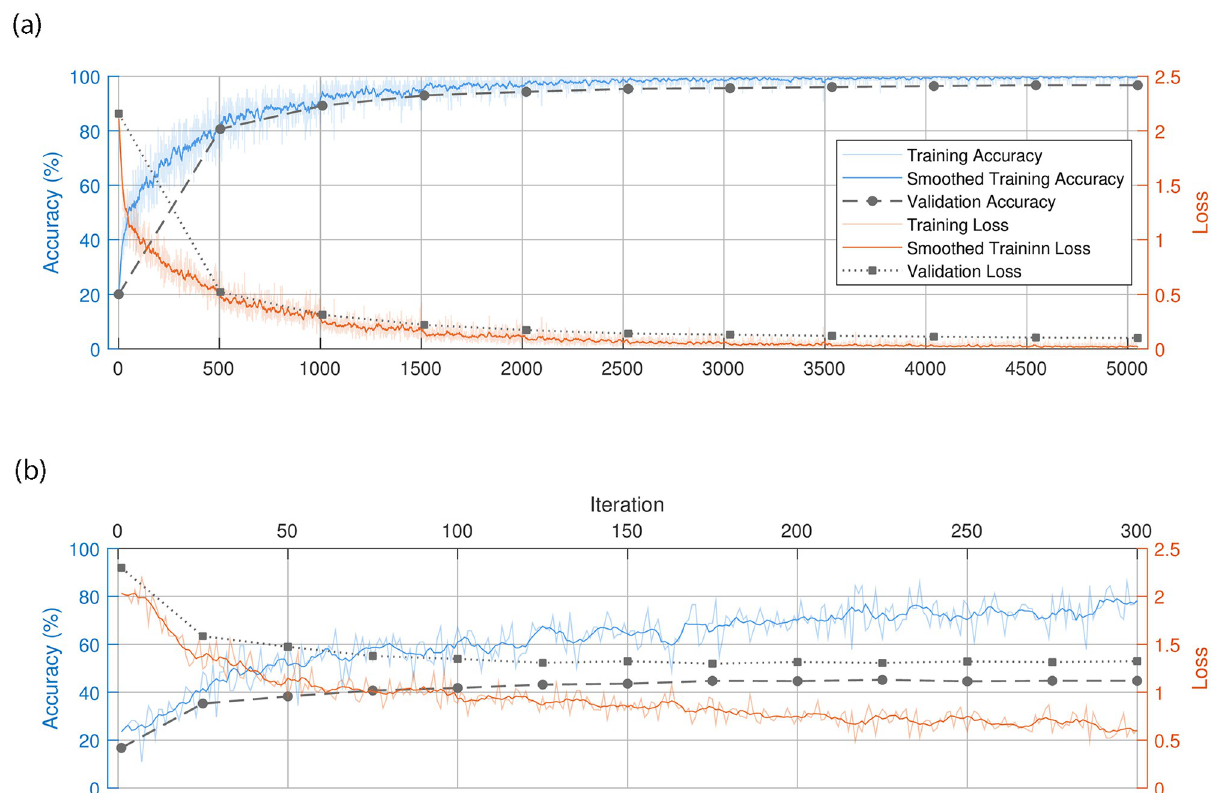
Fig 4. Comparison of reimplementations of the fine-tuning procedure. The top figure depicts the training progress of a fine-tuning procedure with data leakage, while the bottom figure shows the training progress of a fine-tuning procedure without data leakage.